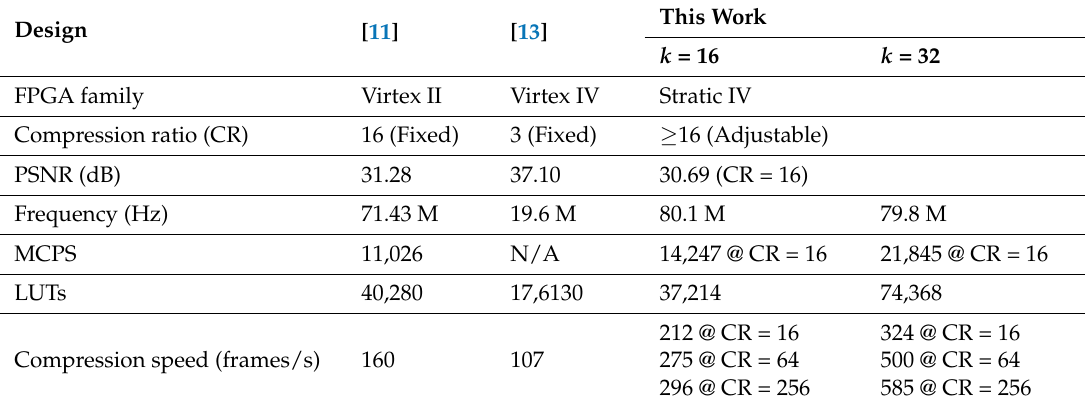
Table 2. Comparison results with the previous VQ (Vector quantization)-based image compression